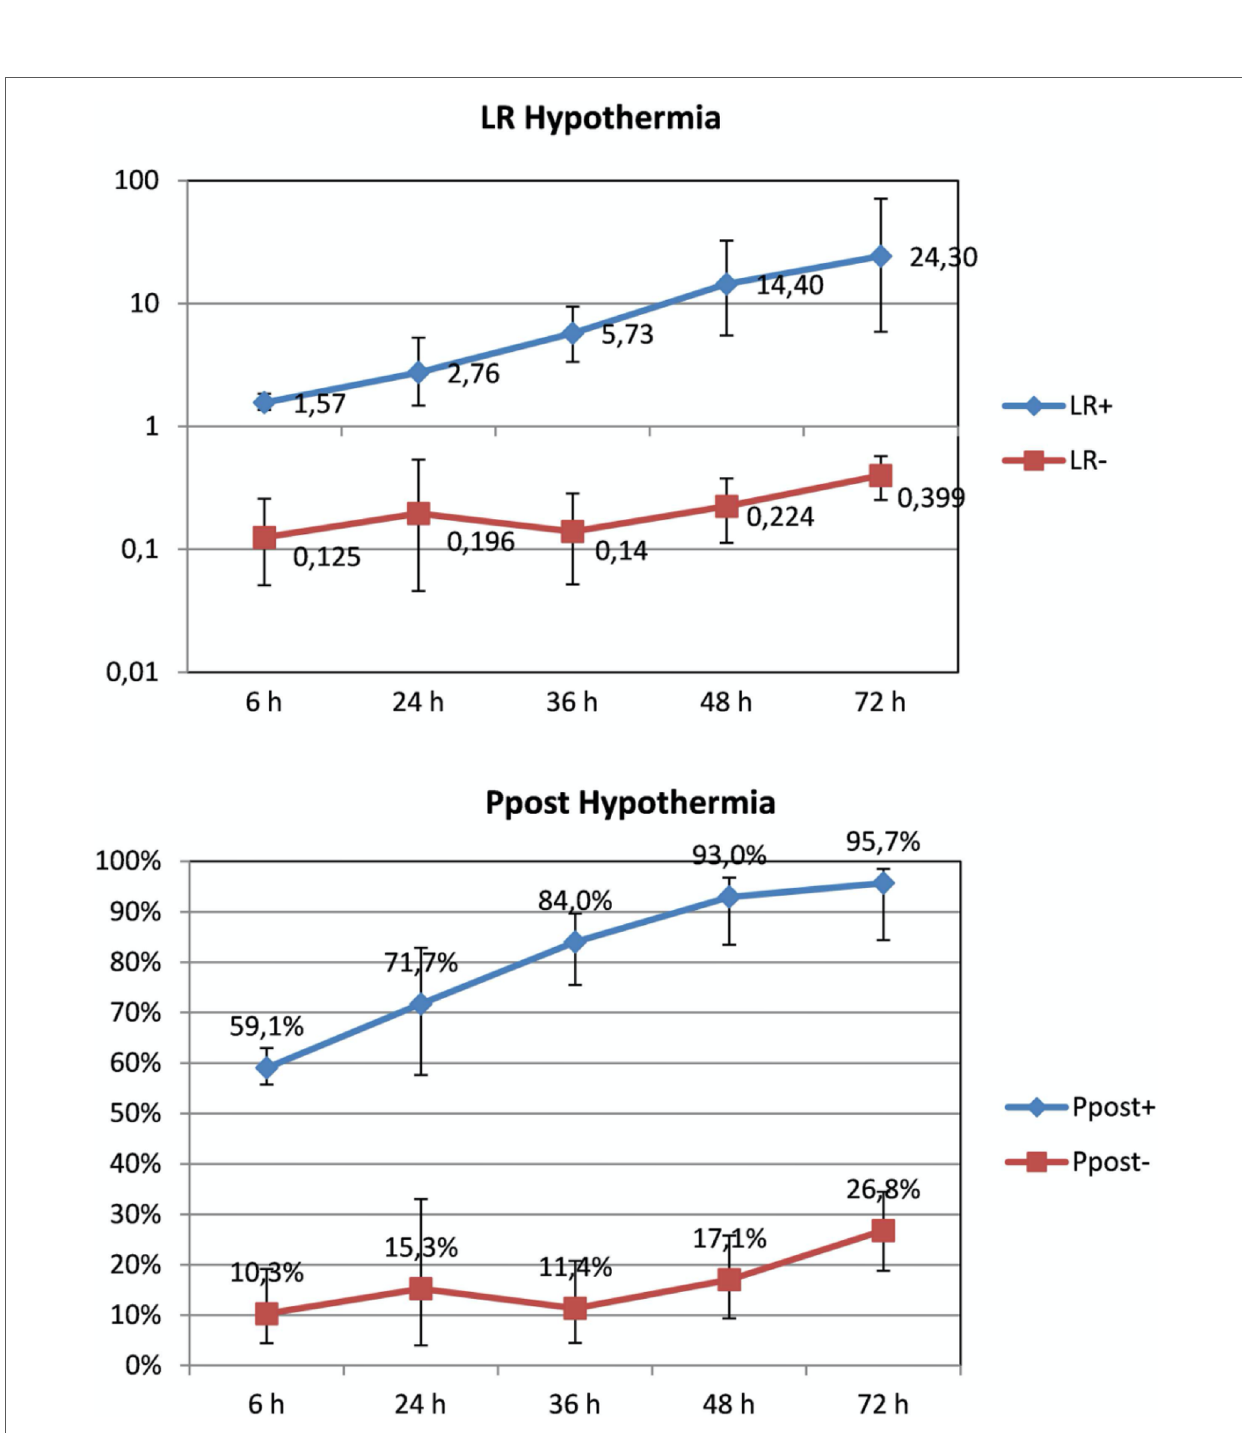
FIGURE 4 Likelihood ratios (LR) and post-test probability (ppost) of abnormal aEEG and adverse neurologic outcome in newborns treated with hypothermia at speci fi c hoursoflife (reproduced withpermission fromDel Río R, ochoaC, alarconA,arnáez J, blanco D, garcía-alix A.Amplitude Integrated Electroencephalogramas a Prognostic Tool in Neonates with Hypoxic-Ischemic Encephalopathy: A Systematic Review. PLoS ONE.